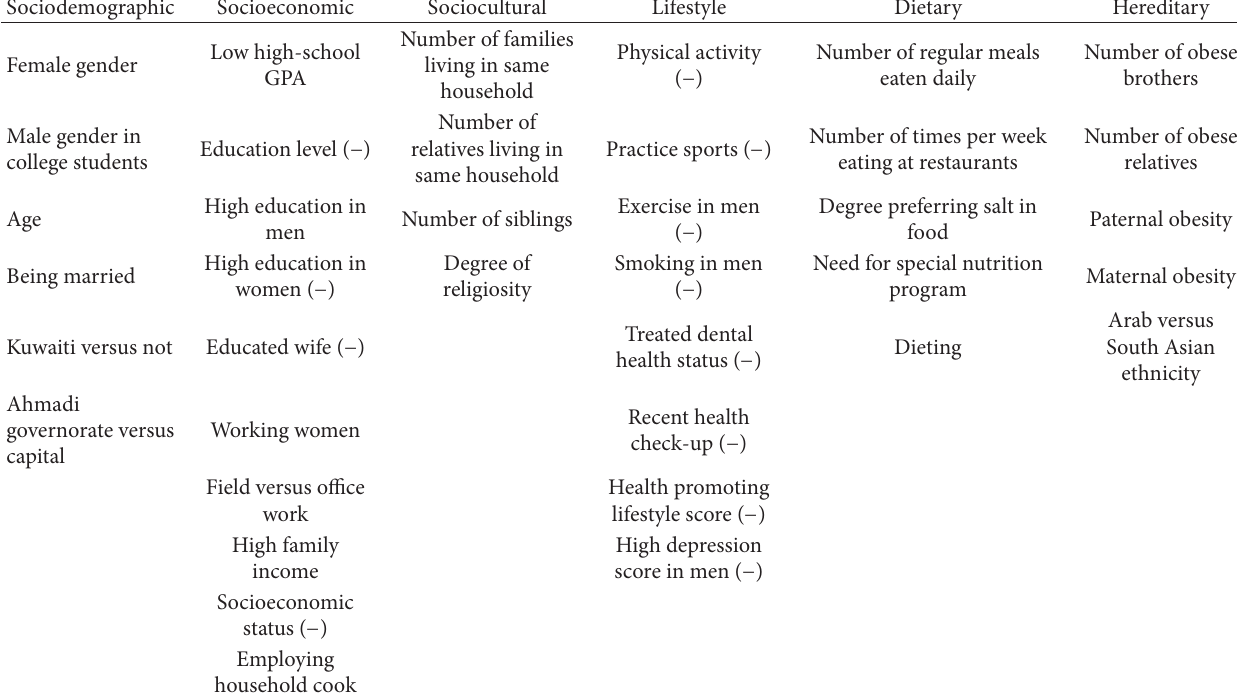
Table 5: Obesity risk factors ∗ reported in reviewed